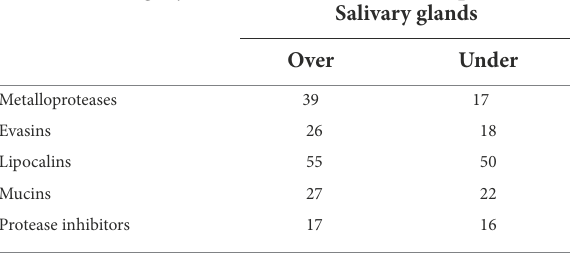
TABLE 3 Secreted differentially expressed transcripts (DET– at least 8 fold over or underexpressed and with a false discovery rate of 0.05 or lower) from A . maculatum salivary glands in response to R . parkeri infection grouped into functional